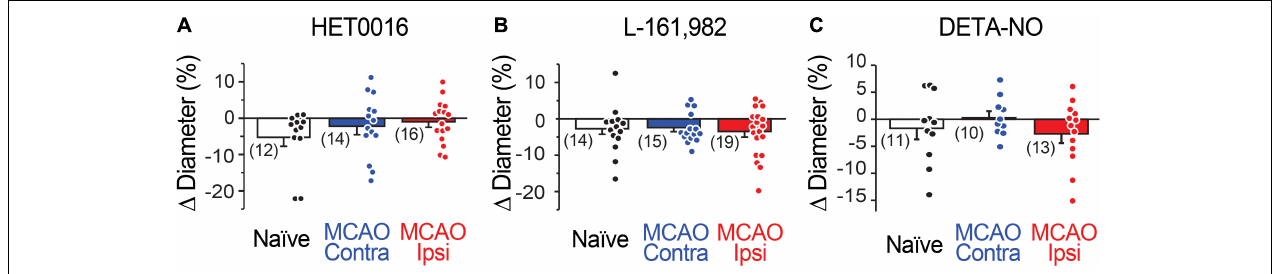
FIGURE 4 | Capillary diameter is not directly altered by 20-HETE, EP4, or NO. Reducing 20-HETE synthesis with HET0016 (A) , blocking the PGE2 receptor EP4 with L-161,982 (B) , or increasing ambient NO level with DETA-NONOate (DETA-NO; C ) does not alter the resting diameter of capillaries (under U46619-mediated